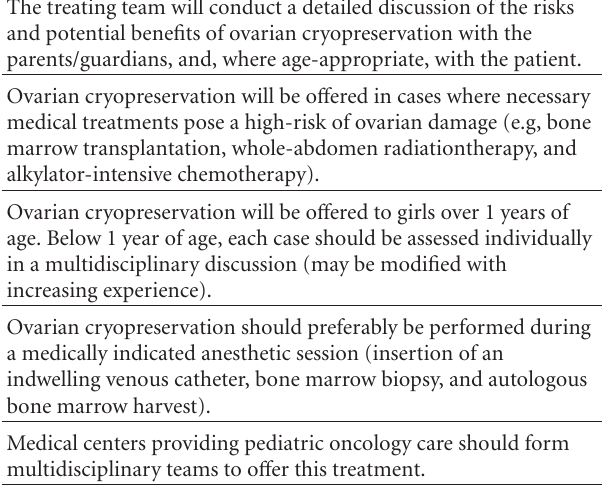
Table 2: Revised guidelines for o ff ering ovarian cryopreservation to premenarcheal girls with